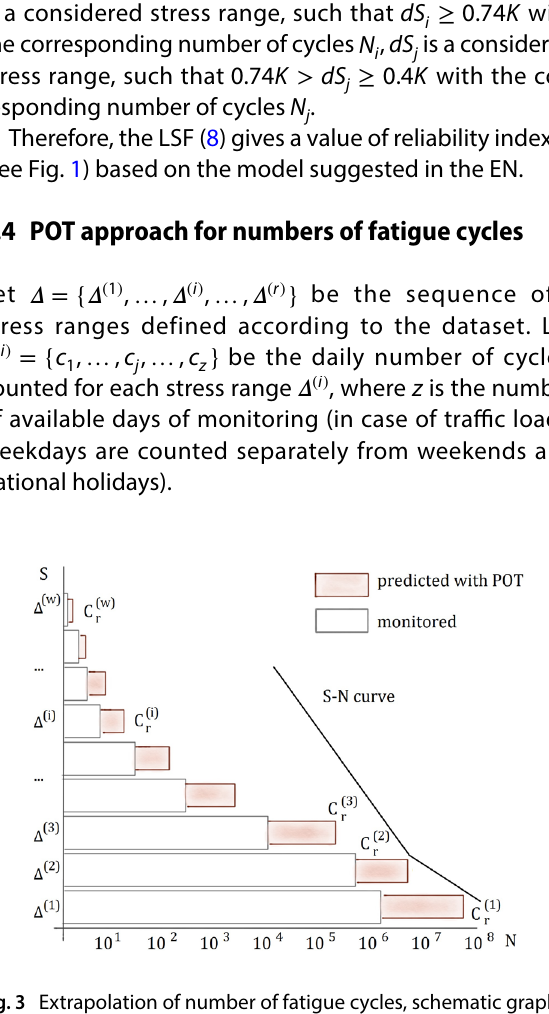
Fig. 3 Extrapolation of number of fatigue cycles, schematic graph